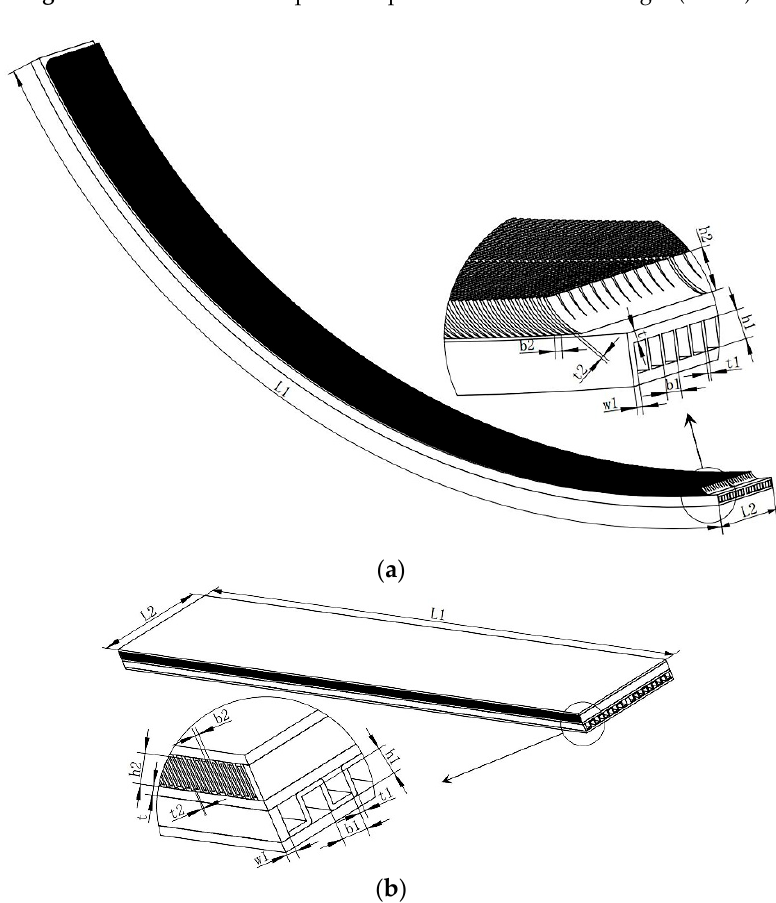
Figure 3. Configuration parameter correspondence between AR and PFHX: ( a ) configuration parameters of AR; ( b ) corresponding configuration parameters of PFHX. Table 2. Configuration parameter values.